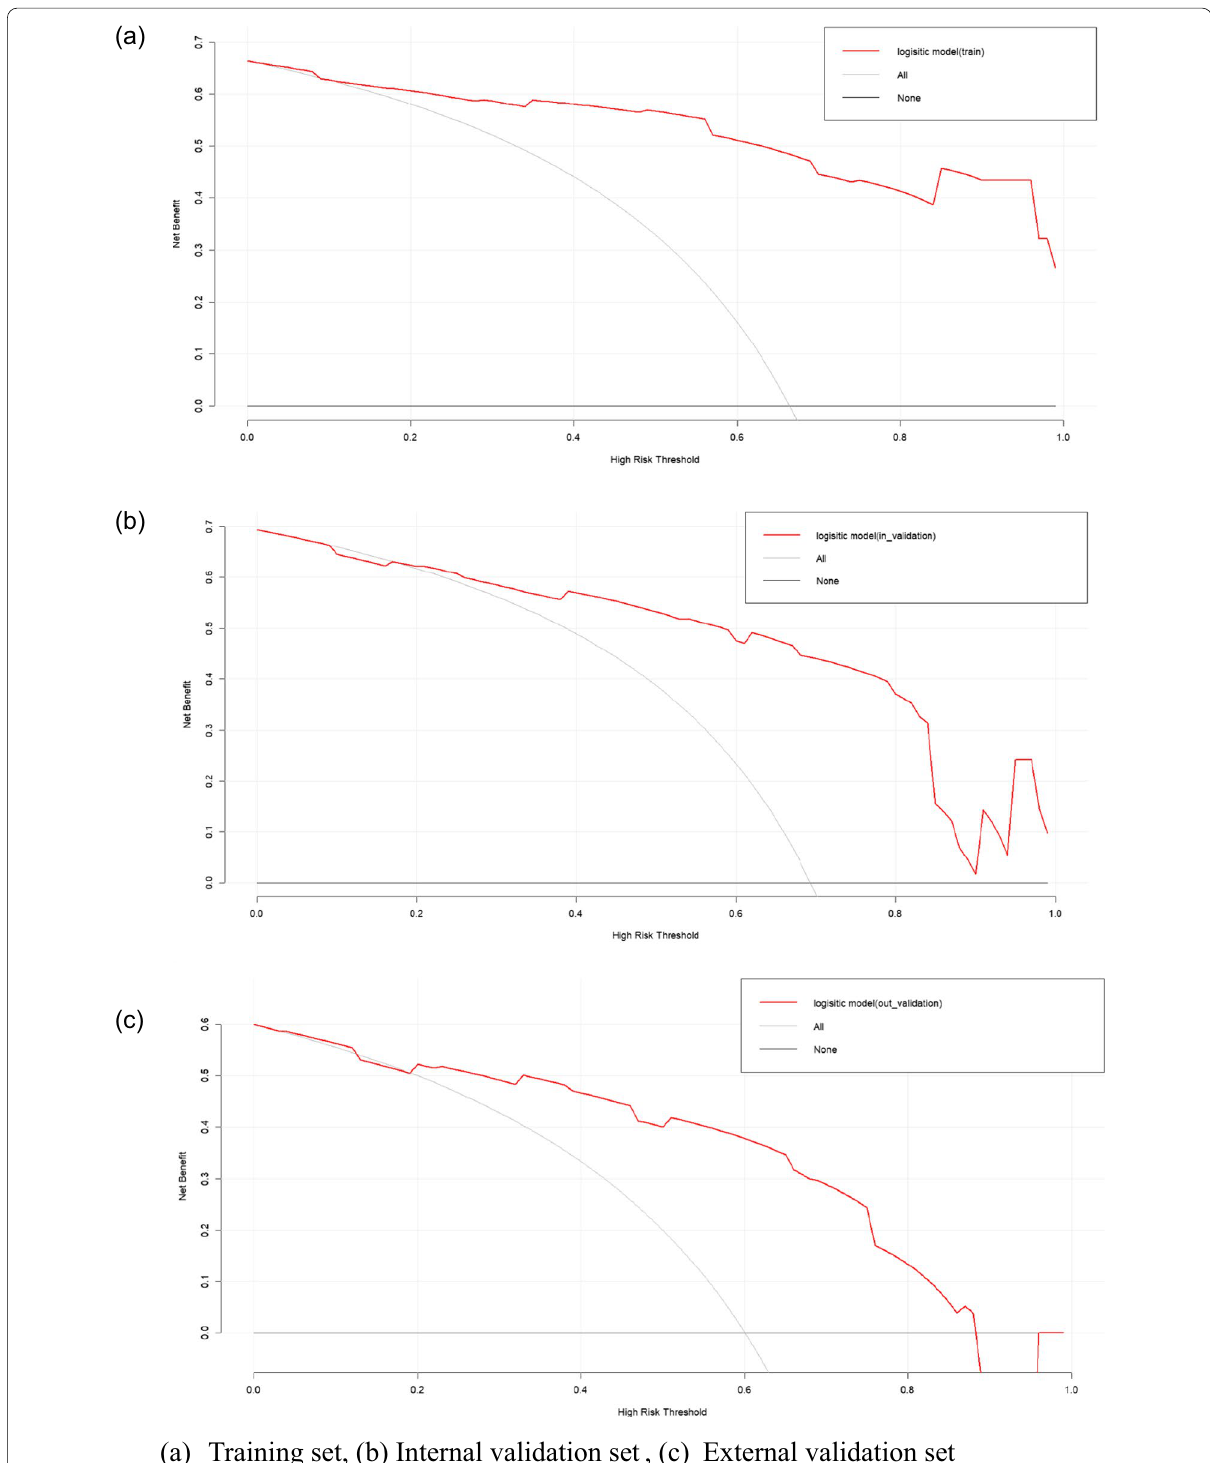
Fig. 6 Decision curve analysis in prediction of